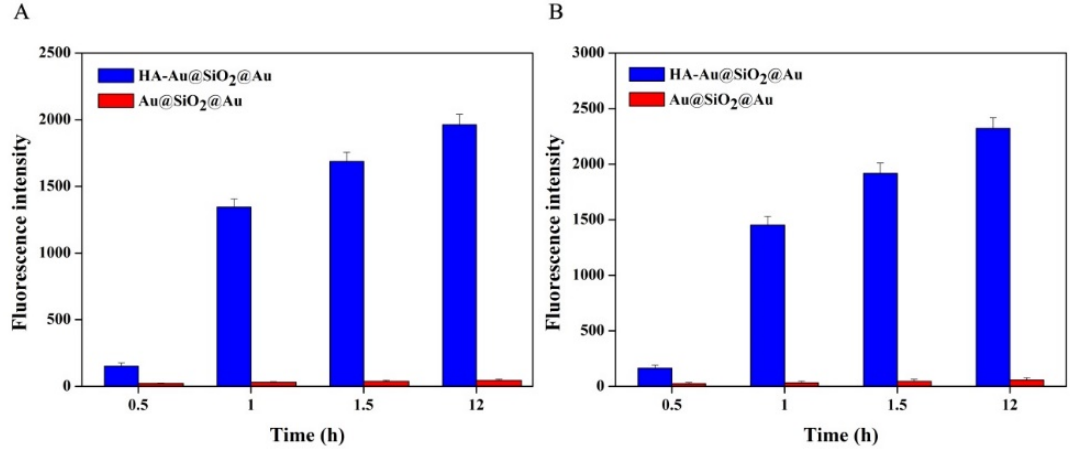
Figure 4. Fluorescence intensity histograms of Au@SiO 2 @Au and HA-Au@SiO 2 @Au nanoparticles in ( A ) prostate cancer cells (PC-3 cells) and ( B ) bladder cancer cells (MB49 cells), respectively.